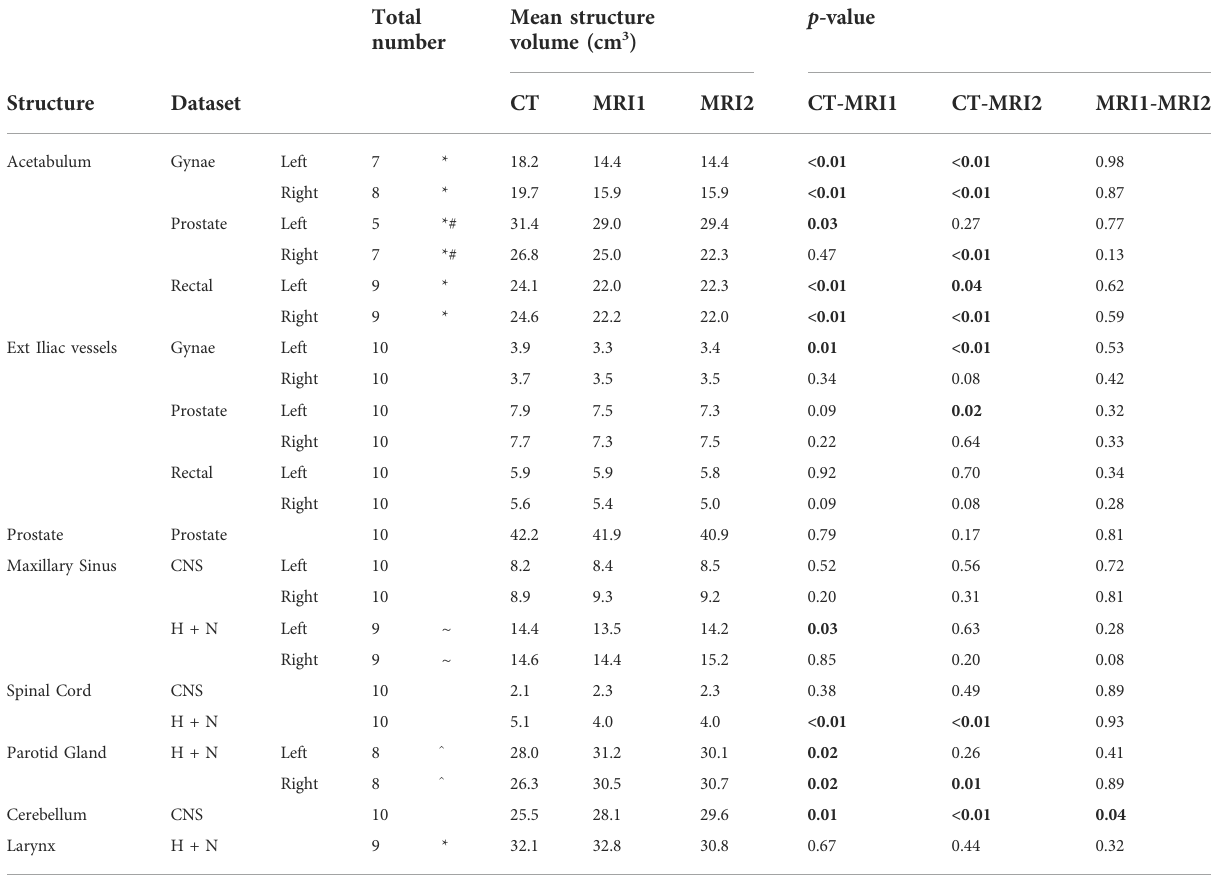
TABLE 1 Mean volume of each contoured anatomical structures (cubic centimeters (cm 3 )) on the CT, MRI1 and MRI2 datasets for the CNS, H + N, gynaecological,prostateandrectalcancerpatientgroups( n =10foreachpatientgroup);and p -valuesforthecomparisonofCTtoeachMRIand the two MRI scans. Statistically signi fi cant differences ( < 0.05) between the datasets are in bold. The numbers of structures included for each dataset are indicated. Where a structure was omitted from the analysis the reason is given below, see key. Total Mean structure p number volume (cm 3 )